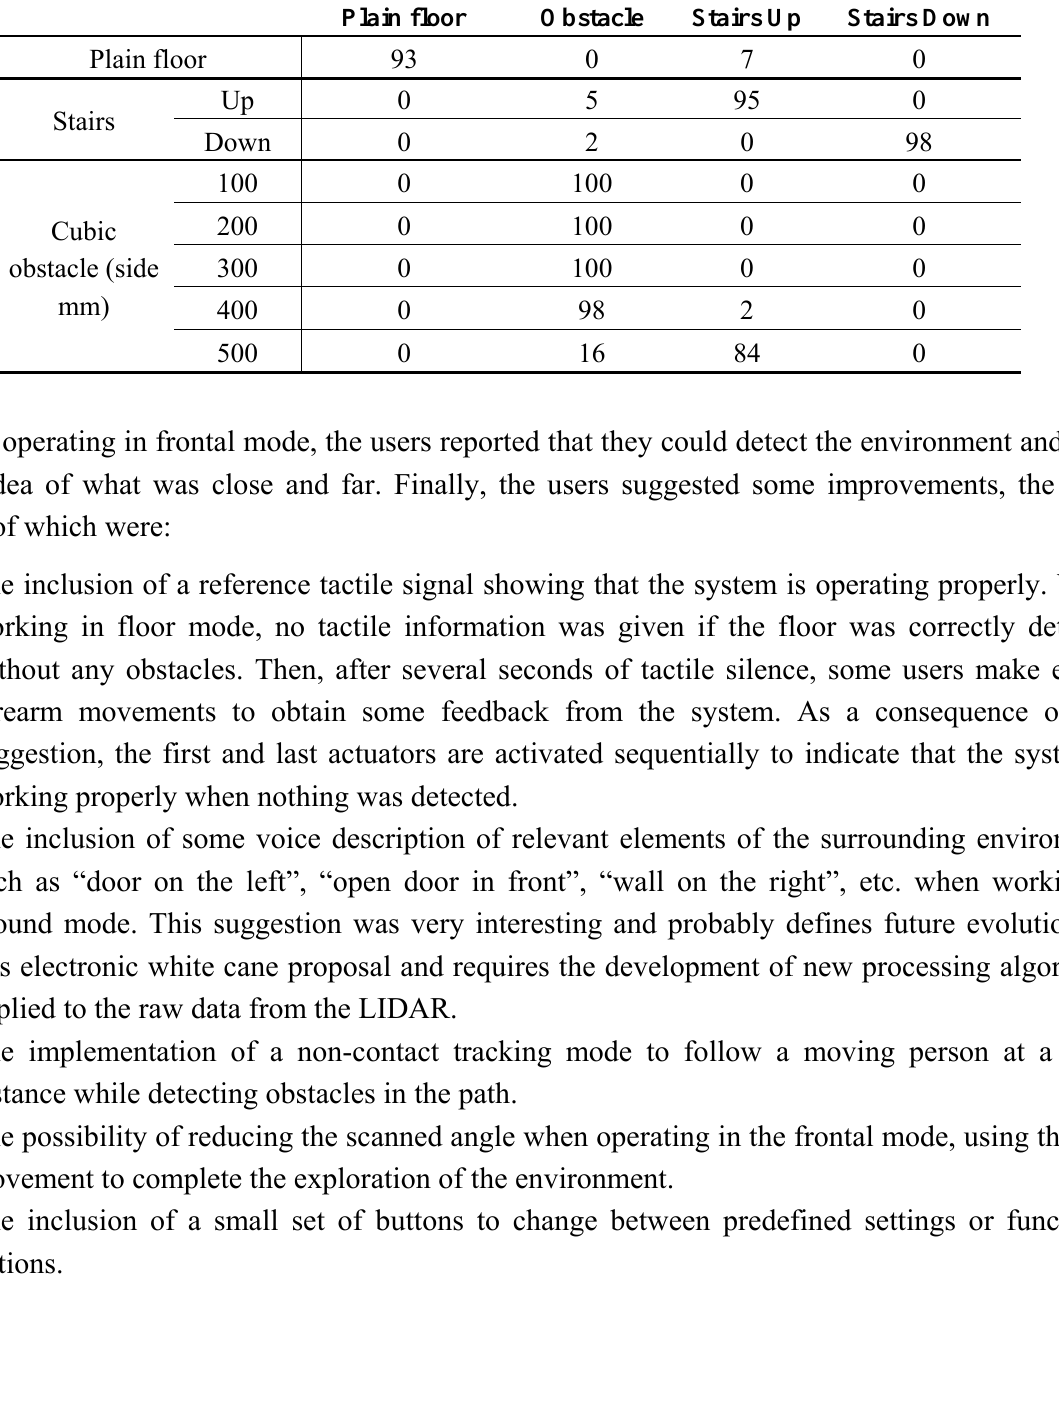
Table 3. Detection results of the electronic white cane operating in floor mode. Detected as (%) Plain floor